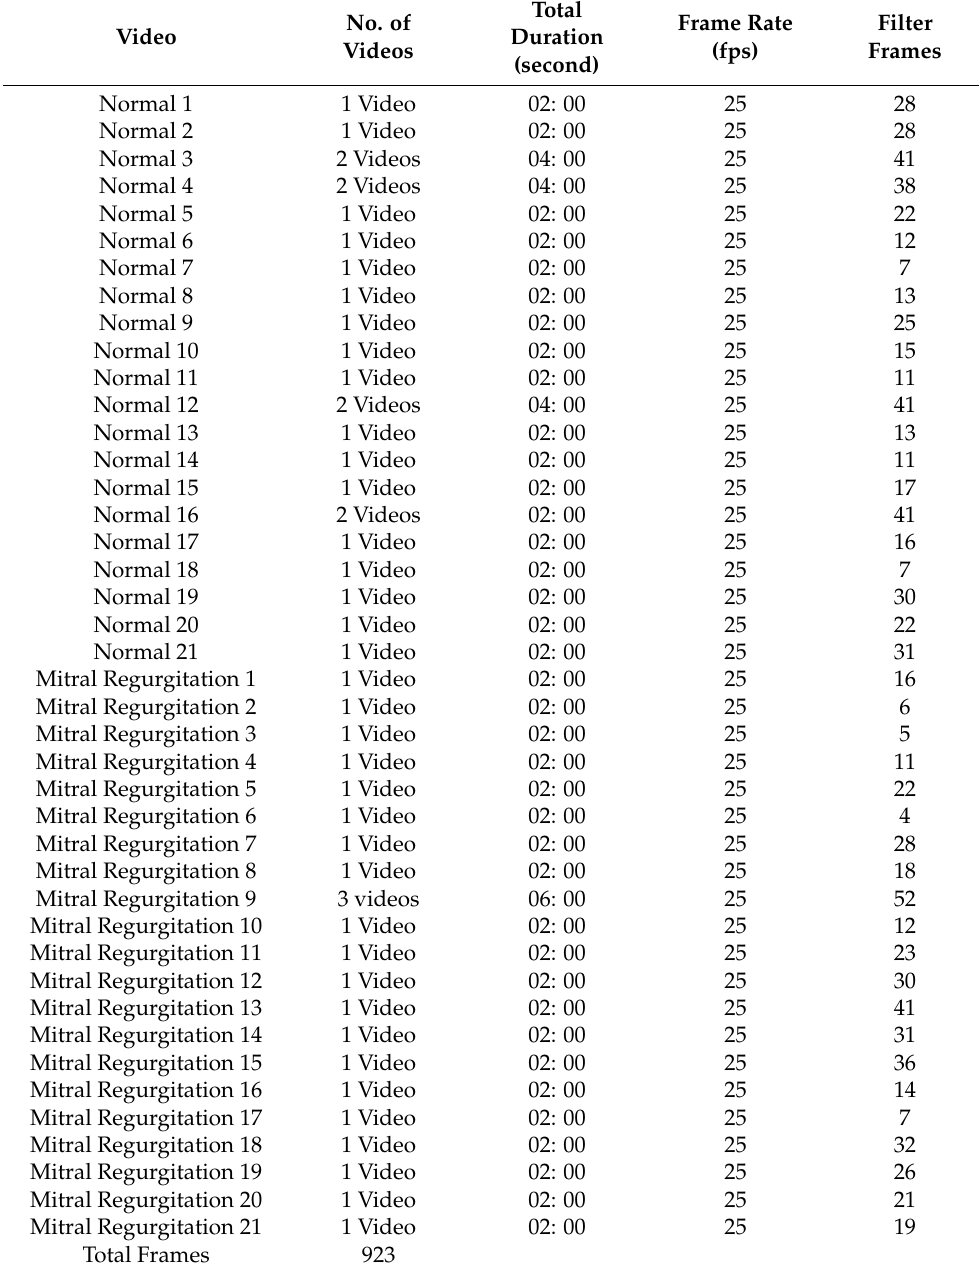
Table 1. No. of images for training and testing.